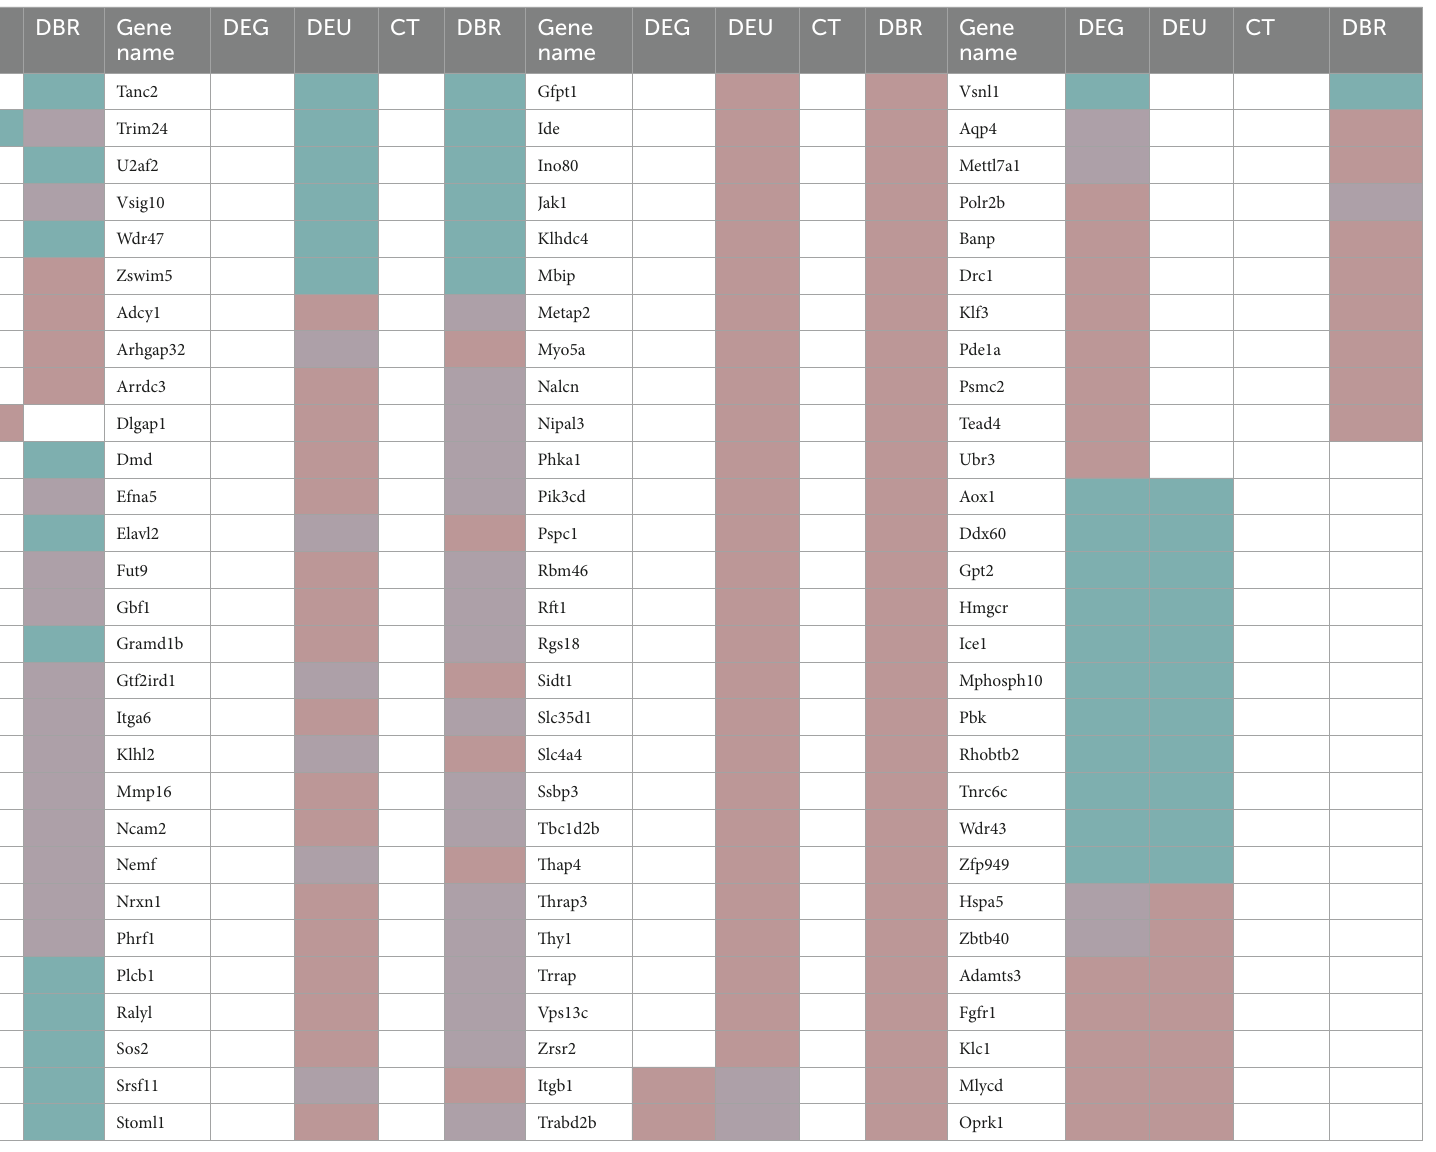
TABLE 1 Genes that appeared in more than one